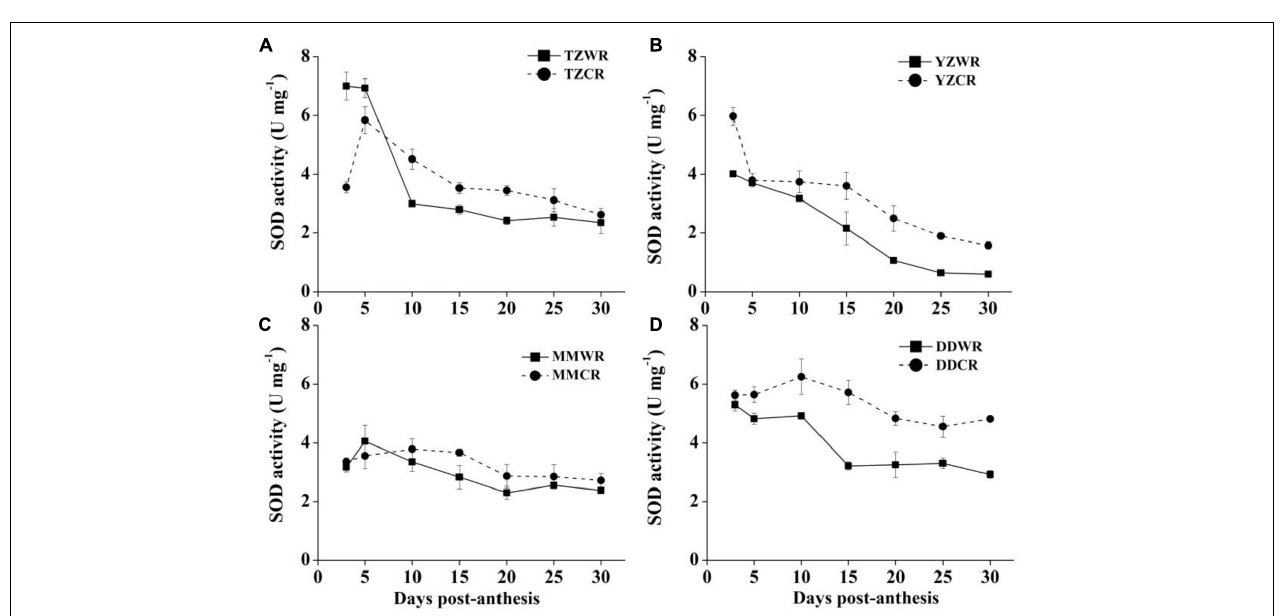
FIGURE 6 | Changes in activities of SOD in weedy rice and cultivated rice. (A) Weedy and cultivated rice from Taizhou; (B) weedy and cultivated rice from Yangzhou; (C) weedy and cultivated rice from Maoming; (D) weedy and cultivated rice from Dandong. TZWR, weedy rice from Taizhou; TZCR, cultivated rice from Taizhou; YZWR, weedy rice from Yangzhou; YZCR, cultivated rice from Yangzhou; MMWR, weedy rice from Maoming; MMCR, cultivated rice from Maoming; DDWR, weedy rice from Dandong; DDCR, cultivated rice from Dandong. Solid line represents weedy rice and dash line represents cultivated rice. The data are presented as mean ± SE ( n =